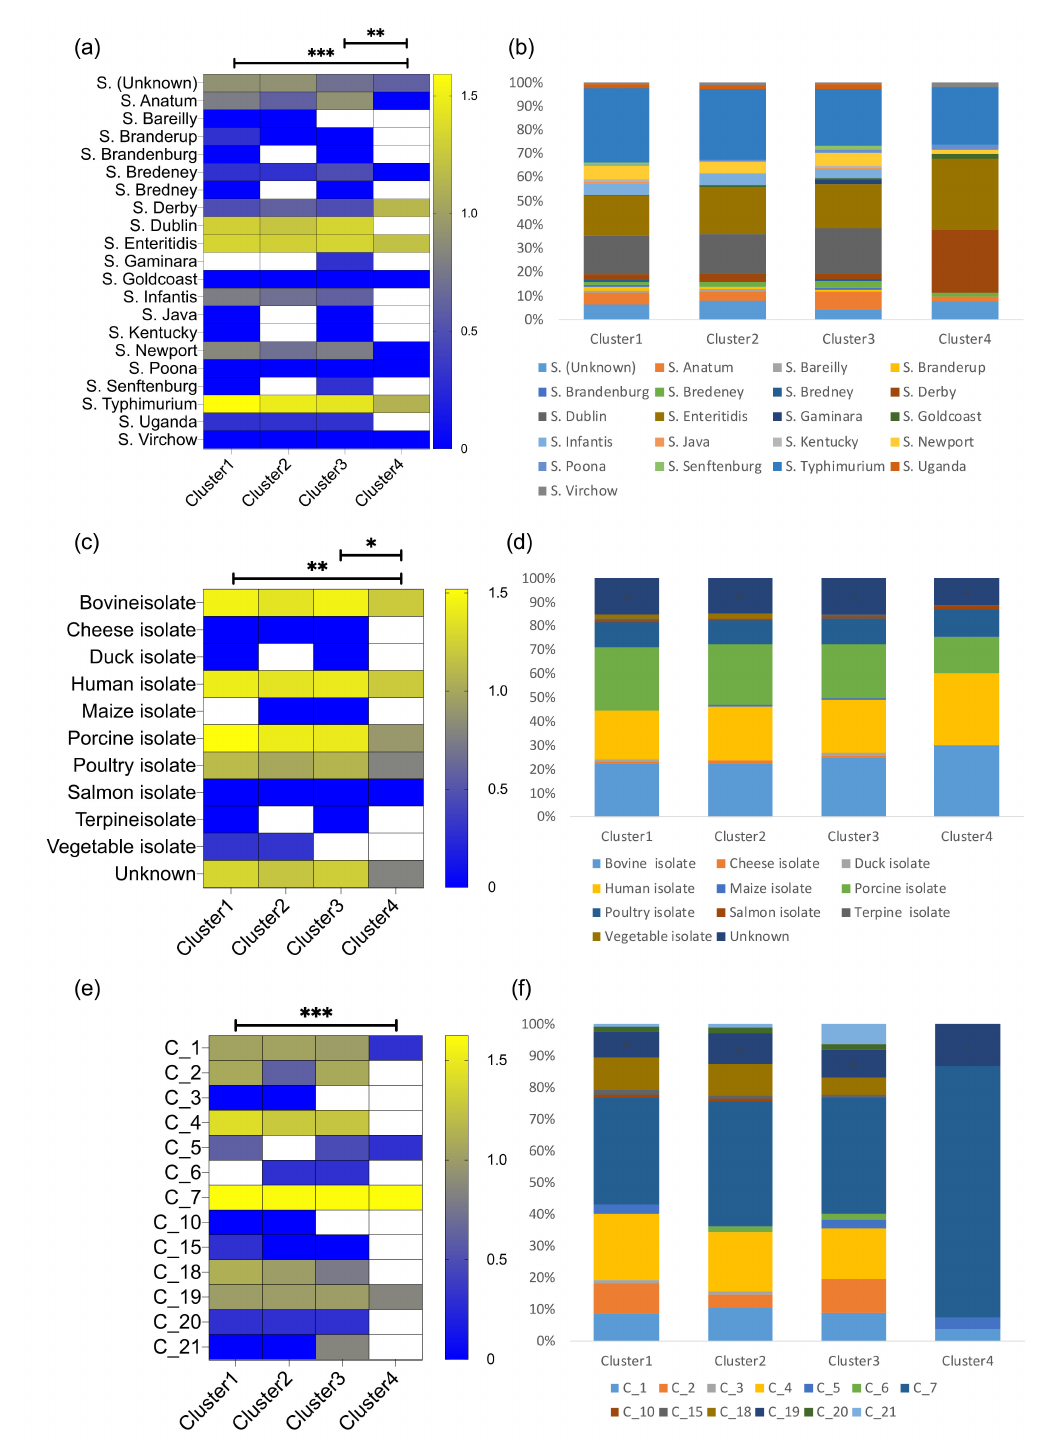
Figure 4. Clusters of Salmonella phage infection profiles. The infection profiles for each Salmonella phage cluster are presented based on three factors: ( a , b ) the type of Salmonella bacteria species that were infected, ( c , d ) the type of envi- ronmental isolates of the bacteria, and ( e , f ) the infection cluster that the bacteria belonged to. For each factor the absolute number of infected Salmonella strains is presented in a heatmap format ( a , c , e ), as well as stacked bar plots representing compositional infection profiles ( b , d , f ). Heatmap color is analogous to the log 10 transformed number of absolute counts of successful infections (high—yellow to low—blue). Significant differences were observed amongst clusters 1 and 4, and 3 and 4. Significance tests: * p < 0.05, ** p < 0.001, *** p <